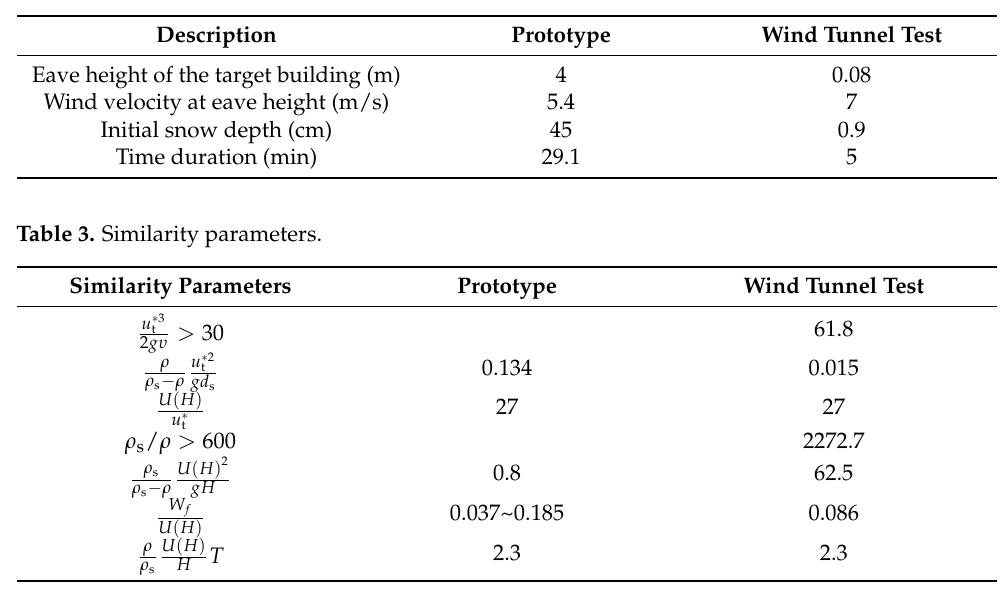
Table 2. Parameters of the wind tunnel tests and prototypes.